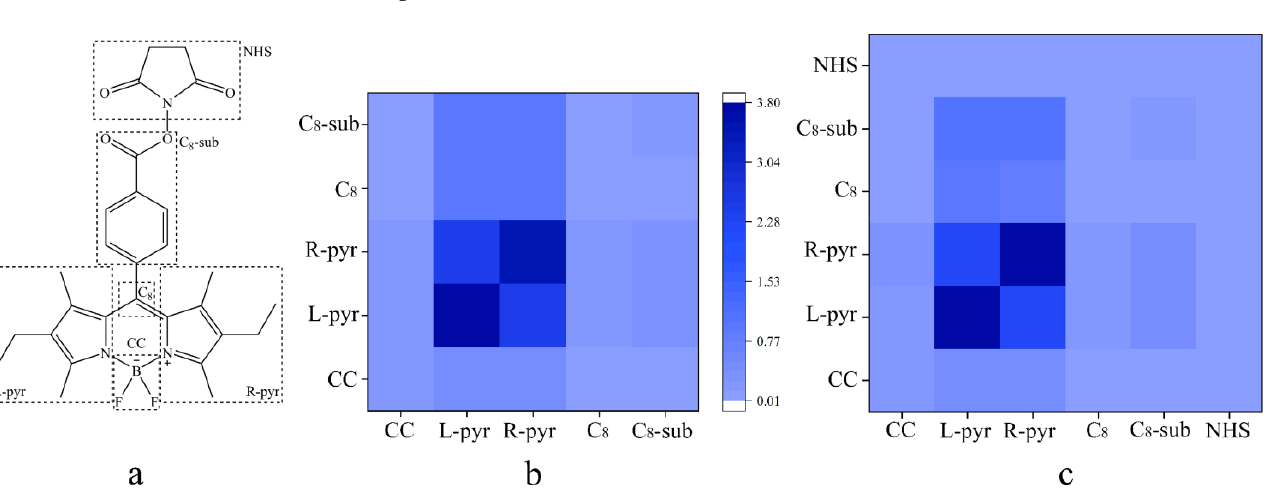
Figure 5. Partitioned transition density for first singlet excitation of COOH-Ph-BODIPY ( b ) and NHS-Ph-BODIPY ( c ) in DMSO and corresponding molecular segments ( a ).